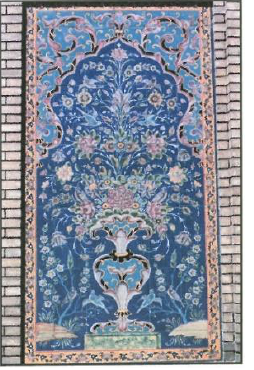
Figure 4. Sepahsalar Mosque, Tehran, Dibaj, 2009